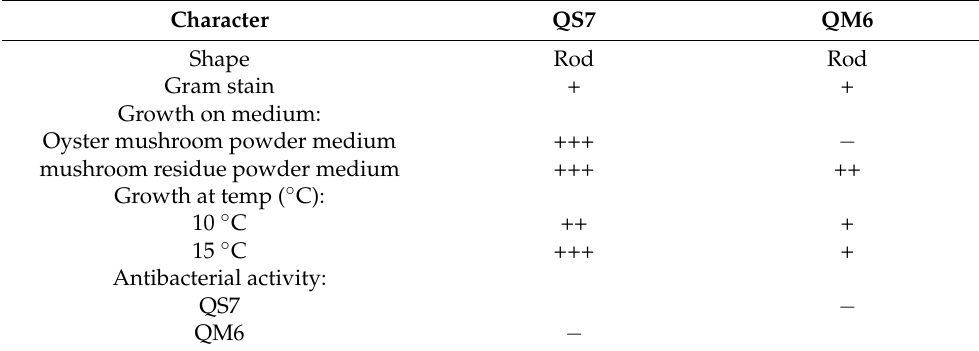
Table 2. Morphological, physiological, and biochemical properties of the strains QS7 and